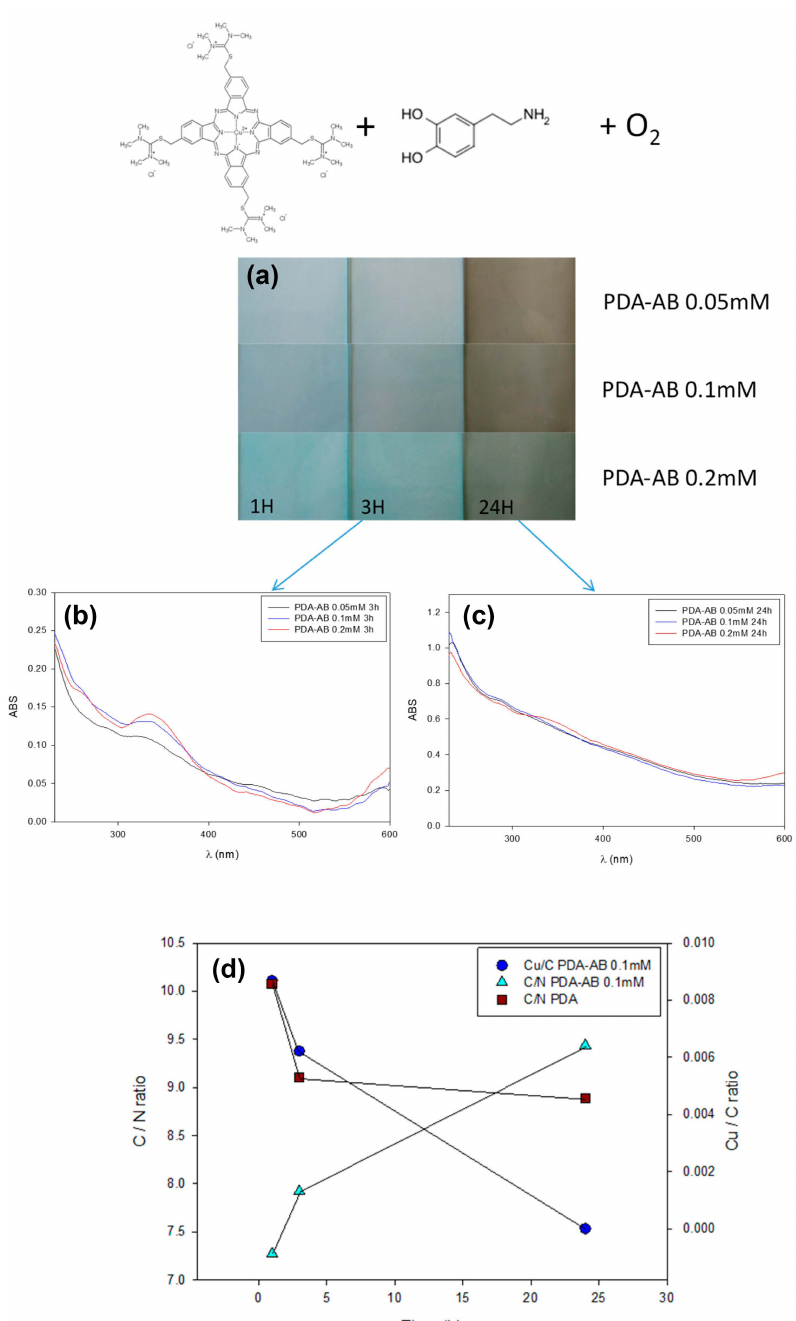
Figure 2. Composites obtained by adding Alcyan Blue (AB) in an oxygenated dopamine solution as shown at the top. ( a ) Digital pictures of glass slides after being put in dopamine–AB blends with AB concentrations of 0.05, 0.1, and 0.2 mM after 1, 3, and 24 h of reaction. The dopamine concentration was the same, 10.6 mM, in all experiments and the films were deposited from 50 mM Tris buffer at pH 8.5 using dissolved O 2 as the oxidant. ( b ) Ultraviolet-visible (UV-Vis) spectra taken on quartz slides put in dopamine–AB mixtures after 3 h of reaction and increasing the AB concentration from 0.05 to 0.2 mM as indicated in the inset. ( c ) UV-Vis spectra taken on quartz slides put in dopamine–AB mixtures after 24 h of reaction and increasing the AB concentration from 0.05 to 0.2 mM as indicated in the inset. ( d ) Evolution with time of the Cu/C ( • ) and the C/N ( (cid:78) ) ratios for the polydopamine (PDA)–AB (0.1 mM) films, and the C/N ( (cid:4) ) ratio for the PDA films. These atomic ratios are obtained from X-ray photoelectron spectroscopy (XPS). Reprinted from [36], Copyright (2015), with permission from